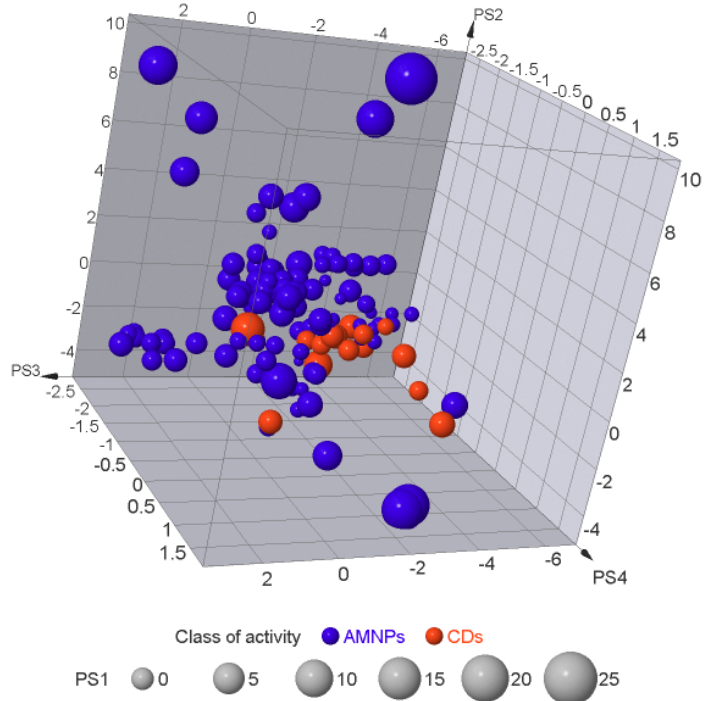
Figure 15. Distribution of AMNPs (blue markers) and CDs (red markers) in chemical space. The coordinates were generated from ChemGPS-NP with dimensions PS1, PS2, PS3, PS4 for size, aromaticity, lipophilicity, and flexibility, respectively. The AMNPs showed higher diversity in comparison with the CDs.